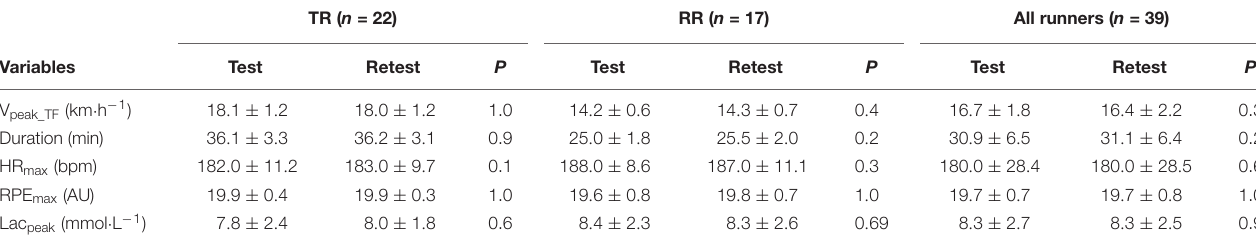
TABLE 1 | Mean values ± standard deviation (SD) for the variables obtained during the maximal incremental tests on the track field for TR, RR, and all runners. TR ( n = 22) RR ( n = 17) All runners ( n = 39)